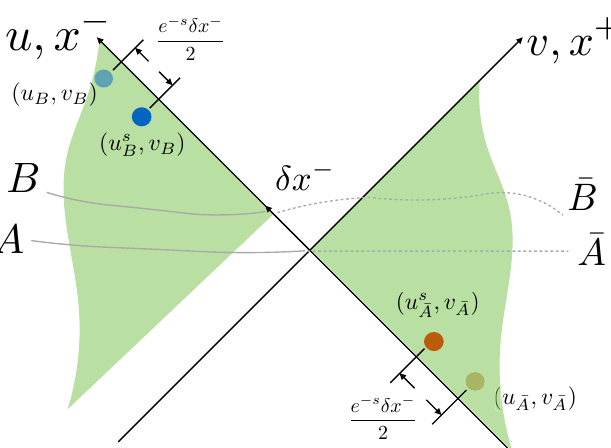
isK B e isK A are defined − s B, ¯ A O